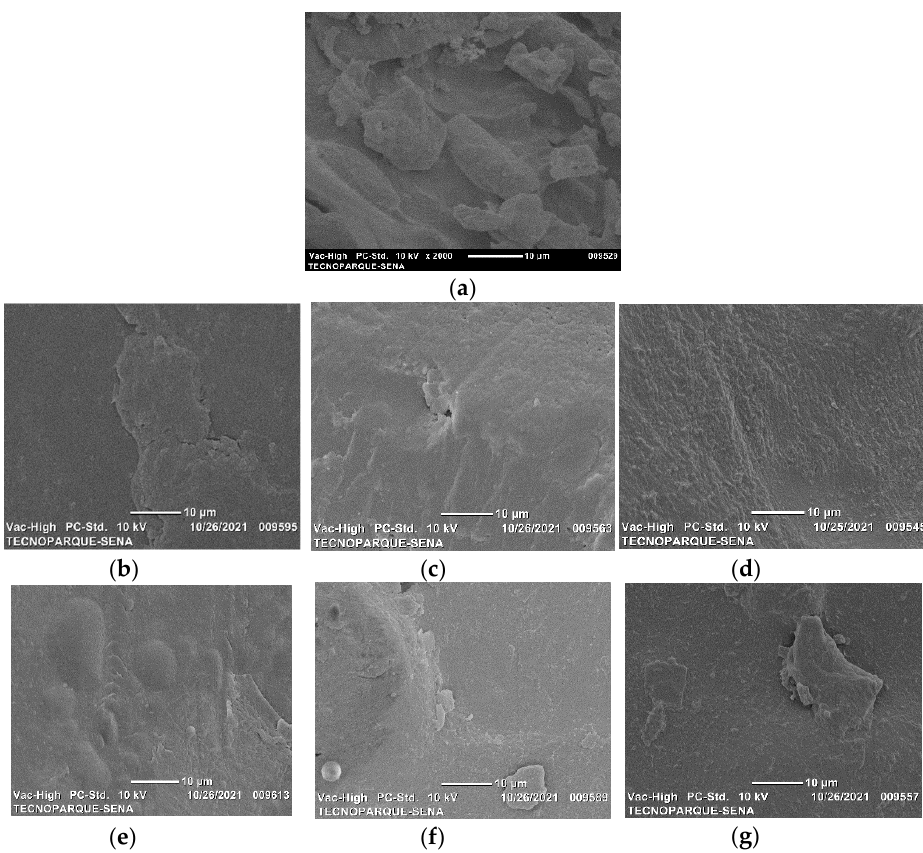
Figure 2. SEM micrographs for achira starch-PVA biodegradable films with MMT nanoclay (0.5, 1.0 and 1.5%), treated with (-s) and without sonication. ( a ) SP, ( b ) SP0.5MMT, ( c ) SP1.0MMT, ( d ) SP1.5MMT, ( e ) SP0.5MMT-s, ( f ) SP1.0MMT-s, and ( g ) SP1.5MMT-s. 2000 ×